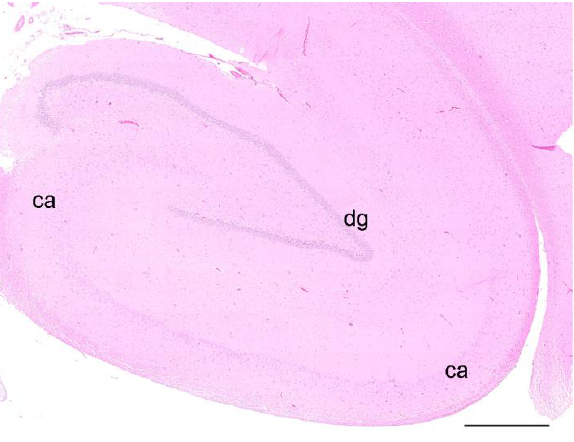
Figure 2. HE staining of the hippocampal formation of an otter, coronal section, showing the dentate gyrus (dg) and the cornu ammonis (ca). Scale bar equals 1 mm; the brightness and contrast have been modified.